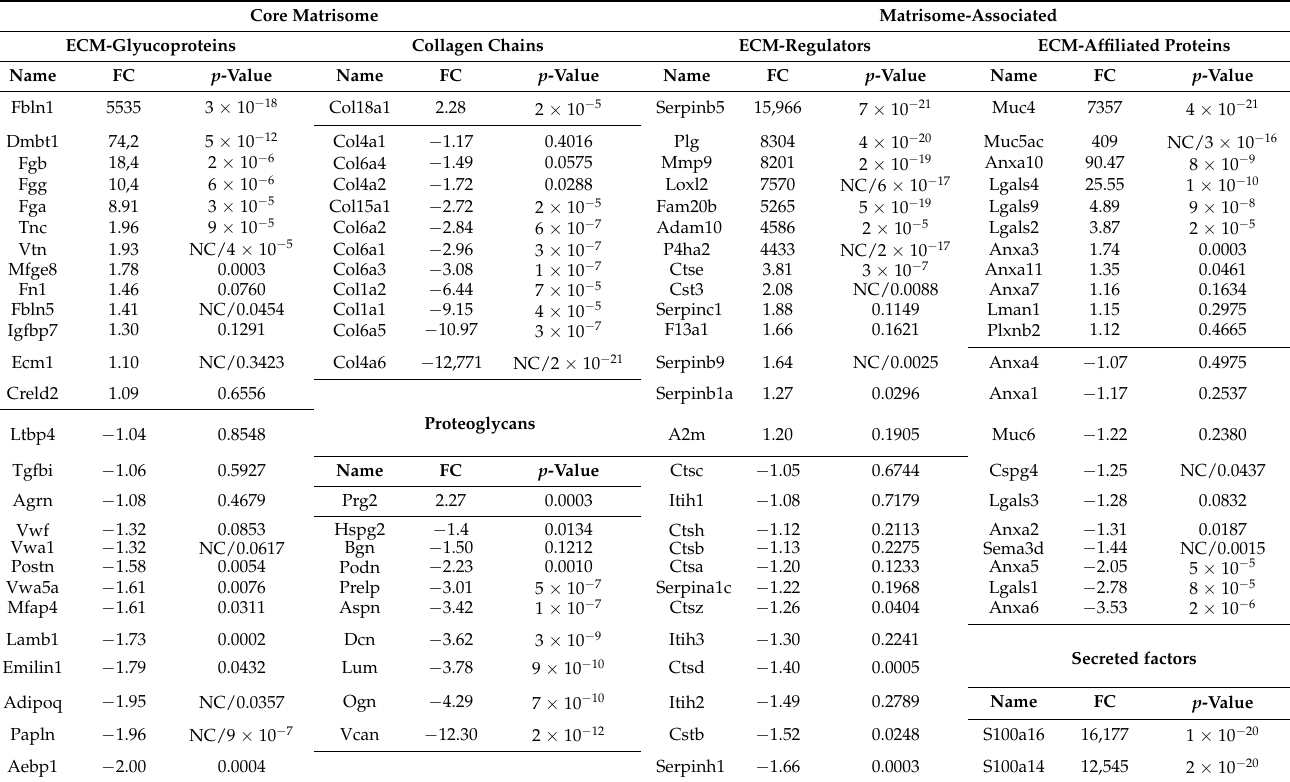
Figure 3. Enriched mesenchyme antrum matrisome in mice upon deletion of telocyte BMP-associated signaling. ( A ) Proteomic data from mesenchyme-enriched antrum tissue isolated from control and BmpR1a △ FoxL1+ mice ( n = 6) were analyzed using ProStar to determine which proteins were significantly modulated. The volcano plot shows all differentially regulated proteins identified following mass spectrometry, highlighting significant matrisome proteins with at least a 1.5-fold change (plotted as log2FC) and a p -value lower than 0.05. Blue dots represent downregulated matrisome proteins; Red dots represent upregulated matrisome proteins. The horizontal line represents the threshold p -value of 0.05. Vertical lines represent the 1.5-fold change threshold (in log2FC). Volcano plot was generated using GraphPad Prism version 9.4.1. ( B ) Pie chart indicates the number of matrisome proteins identified in mesenchyme-enriched antrum tissue according to categories (core matrisome proteins in green and matrisome-associated proteins in black). Table 2. Total Enriched mesenchyme from antrum tissue.